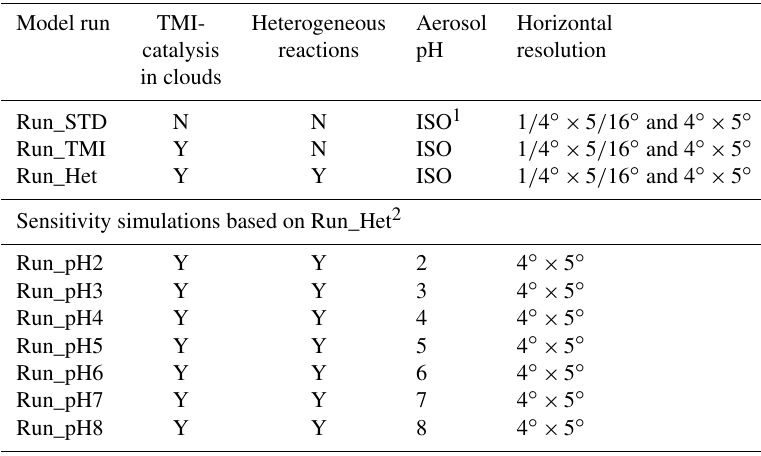
Sensitivity simulations based on Run_Het